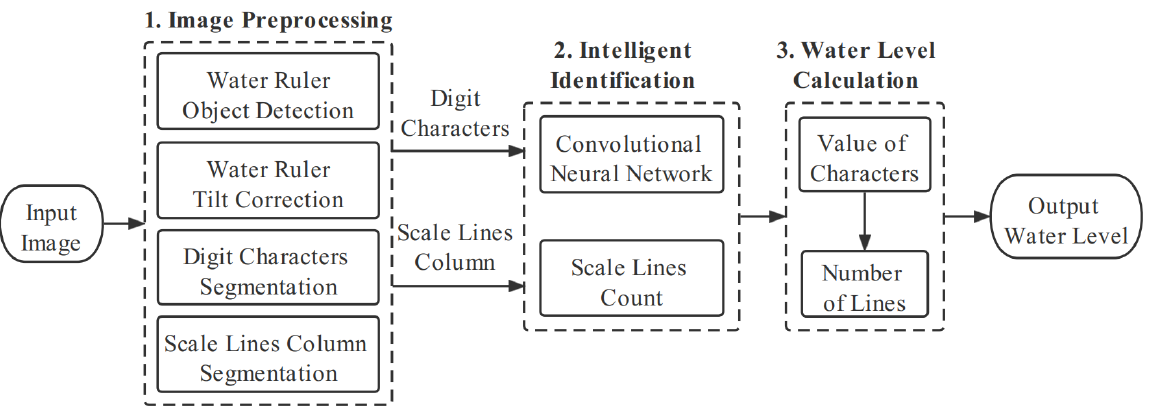
Figure 5. Overview of water level image recognition system.